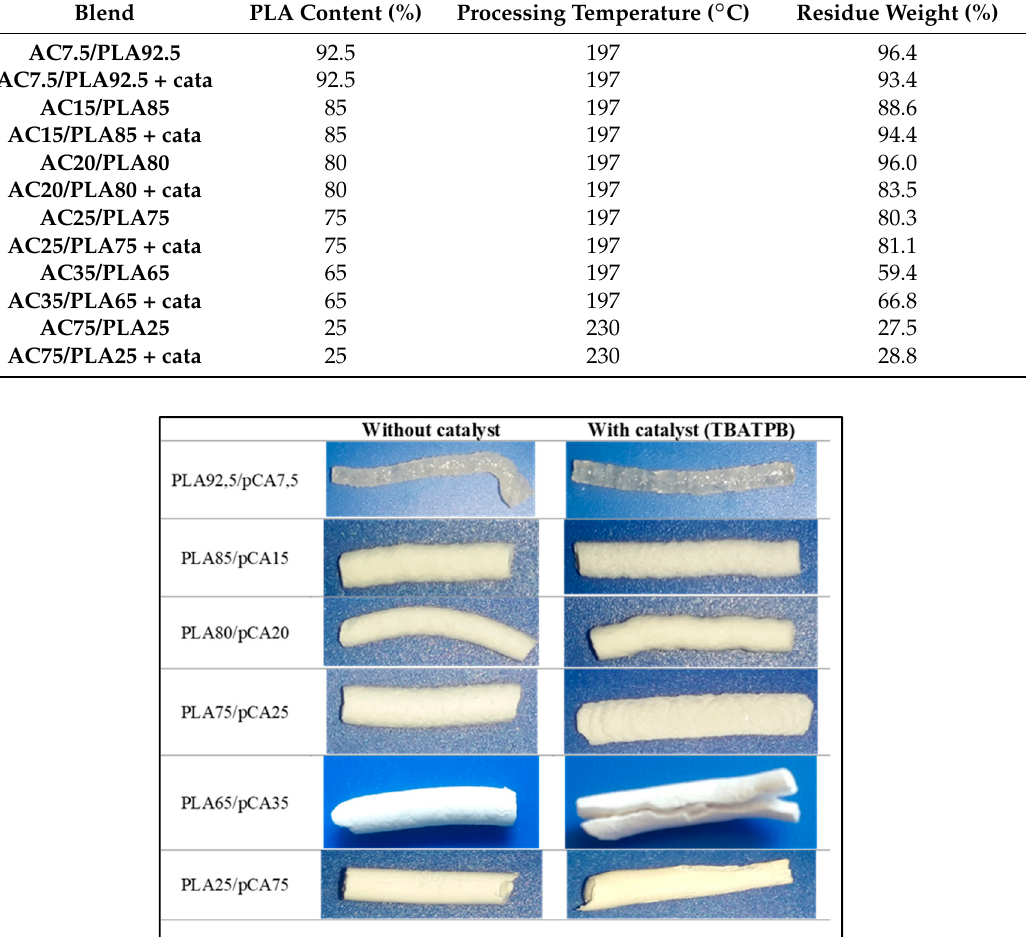
Figure 10. Pictures of residues after dissolution tests carried out on extruded strands of PLA/pCA blends obtained with or without TBATPB.